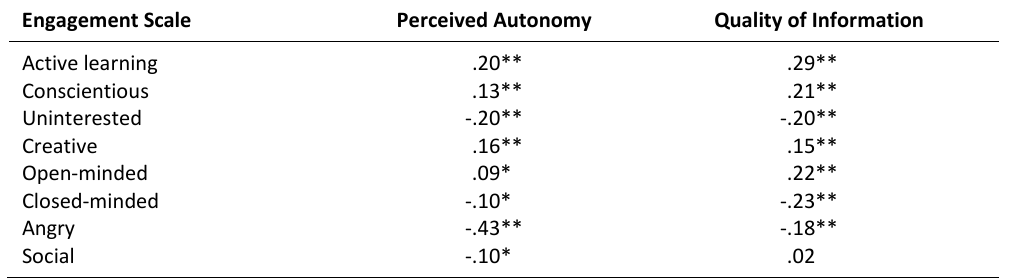
Table 7. Correlations between Engagement Scales and Task Perceptions in Study 2 Engagement Scale Perceived Autonomy Quality of Information Active learning .20** .29** Conscientious .13** .21** Uninterested -.20** -.20** Creative